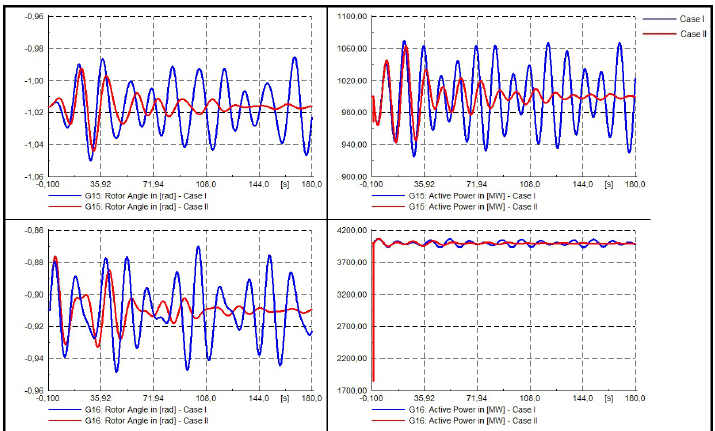
Figure 30. Rotor angle [rad] and Active Power [MW]-three phase fault at Line 18–50. 2. Three phase fault at Line 60-61